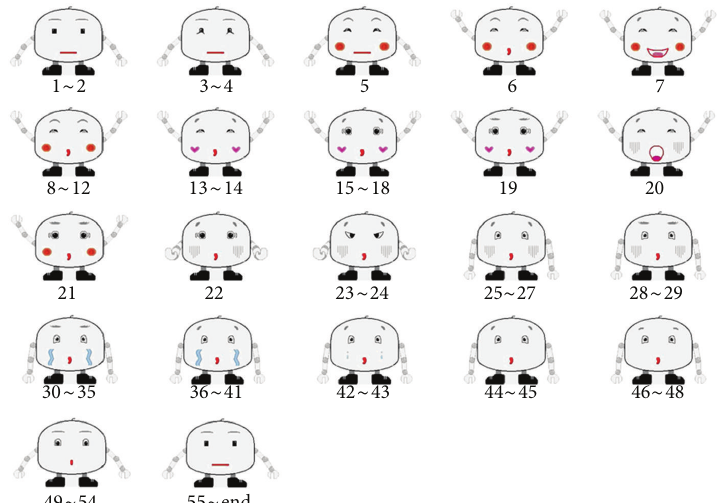
Figure 10: The emotional expressions based on emotions generated by senior